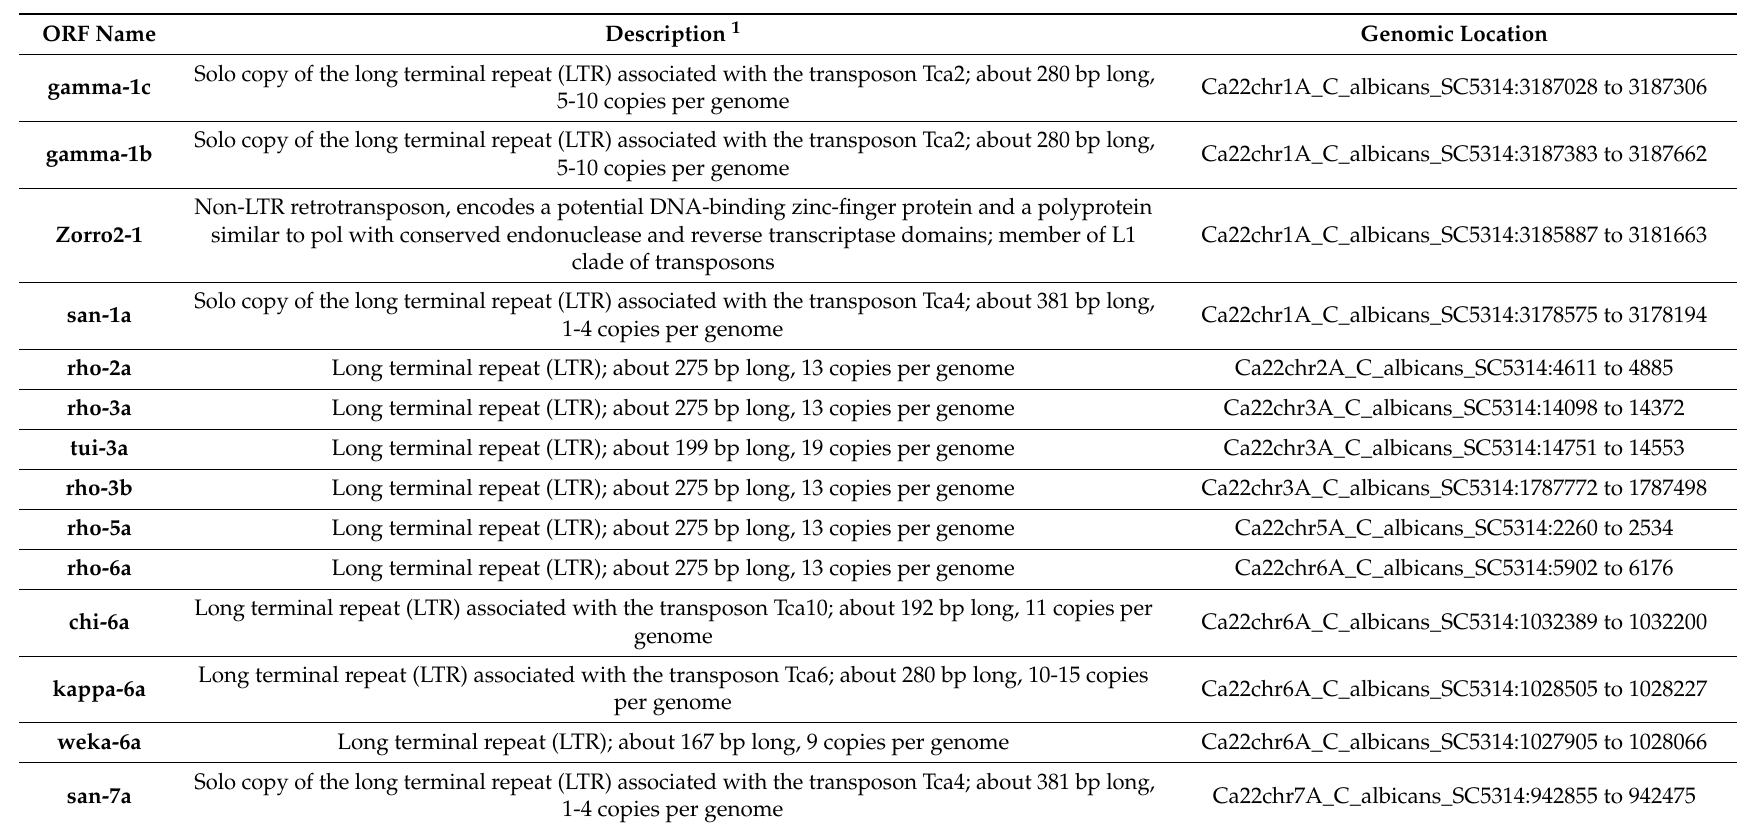
Table 3. C. albicans subtelomeric LTRs and